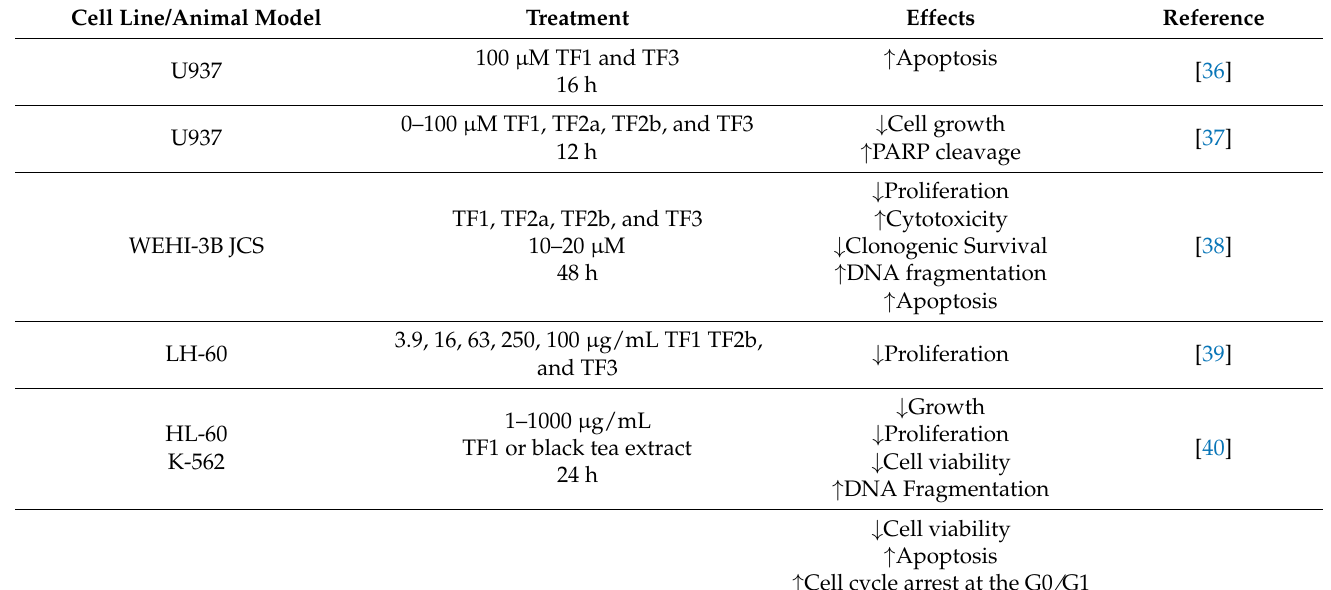
(Table 4) [38]. TF2b inhibited tumor formation to the greatest extent while TF1 was unable to inhibit tumor formation [38]. Table 4. Effects of theaflavins in leukemic